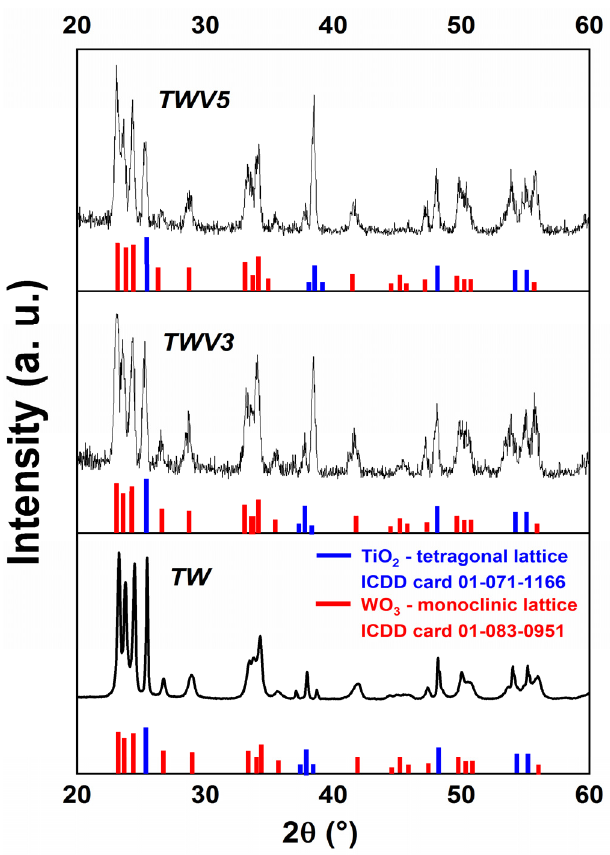
Figure 1. XRD spectra of the TW, TWV3 and TWV5 nanostructures. The colored bars represent the Figure 3. XRD spectra of the TW , TWV3 and TWV5 nanostructures. The colored bars represent crystallographic planes described in the TiO 2 and WO 3 ICDD cards. the crystallographic planes described in the TiO (cid:2870) and WO (cid:2871) ICDD cards. Table 1. Lattice constants and crystallite size of titanium dioxide in TW, TWV3, and TWV5 MON. The TiO (cid:2870) crystal constants in the TW sample (Table 1) also show similar results to Lattice Parameters (Å)